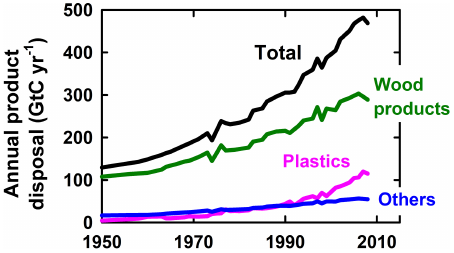
Figure 4. Annual rates of disposal of harvested-wood products, plastics and other carbon containing compounds. Based on data given in Lauk et al.